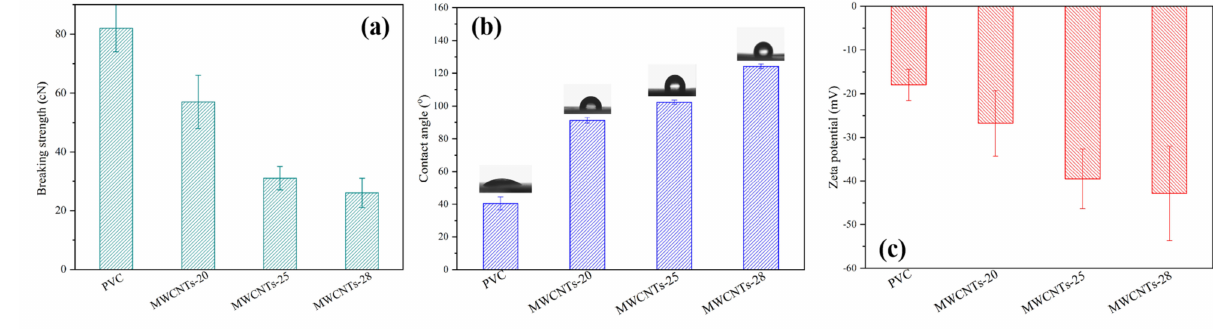
Figure 7. Breaking strength (23 cm × 16 cm area) ( a ), contact angle ( b ), and zeta potential ( c ) of PVC, MWCNTs-20, MWCNTs-25, and MWCNTs-28